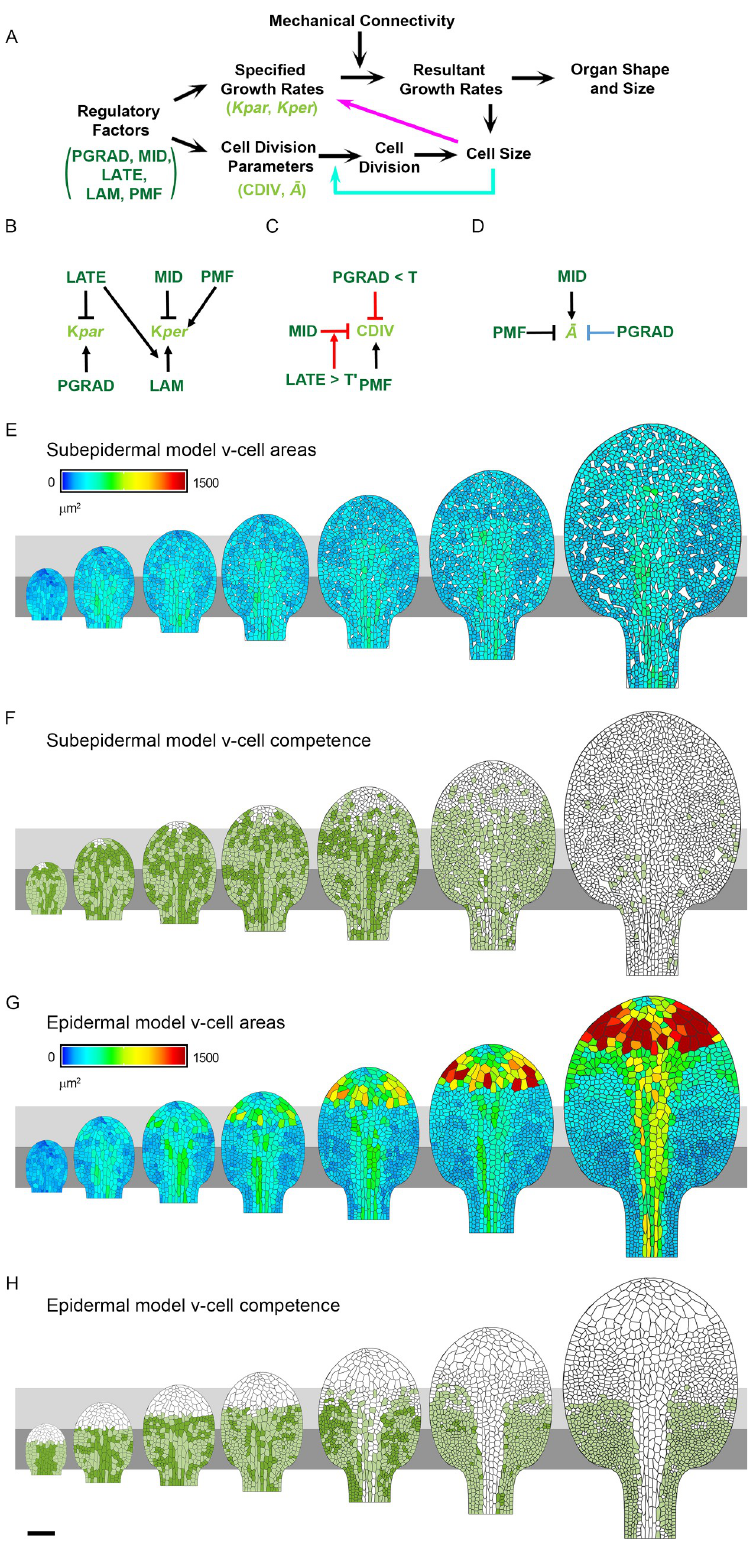
Fig 8. Model regulatory network and output. ( A ) Schematic showing how spatiotemporal regulatory factors (PGRAD, MID, LATE, LAM, PMF) act on components of specified growth ( K par , K per ) and cell division (CDIV and Ā